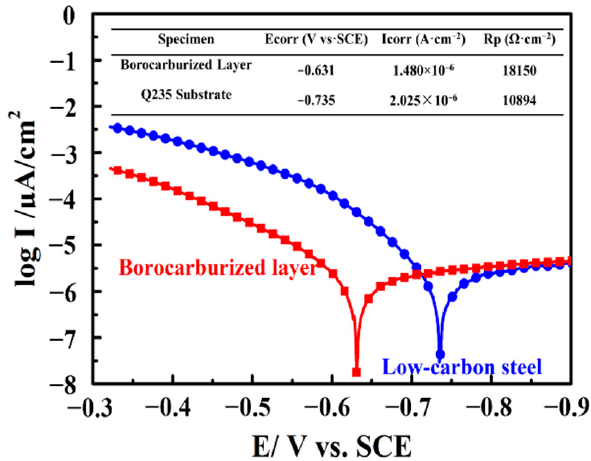
Figure 8. Potentiodynamic polarization curve of the borocarburized layer and substrate.